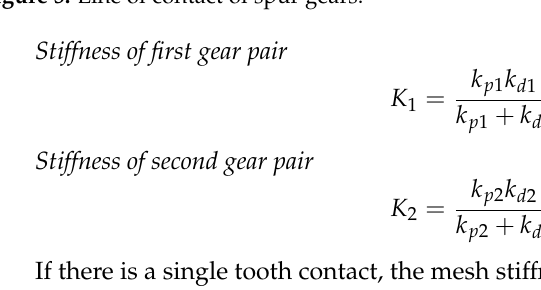
Figure 5. Line of contact of spur gears.